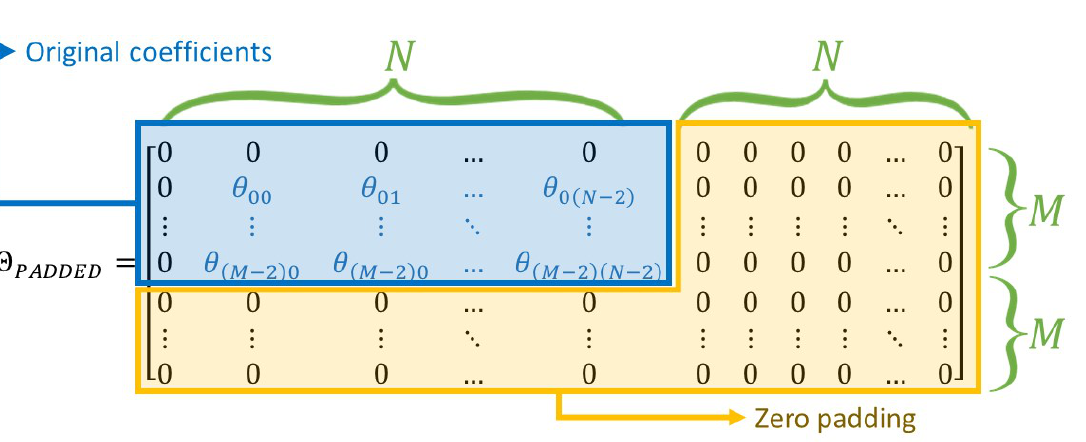
Figure 3. Matrix structure for the zero padding FFT. The blue block contains the original Fourier coefficients θ mn . The remainder of the matrix is filled with zeros.